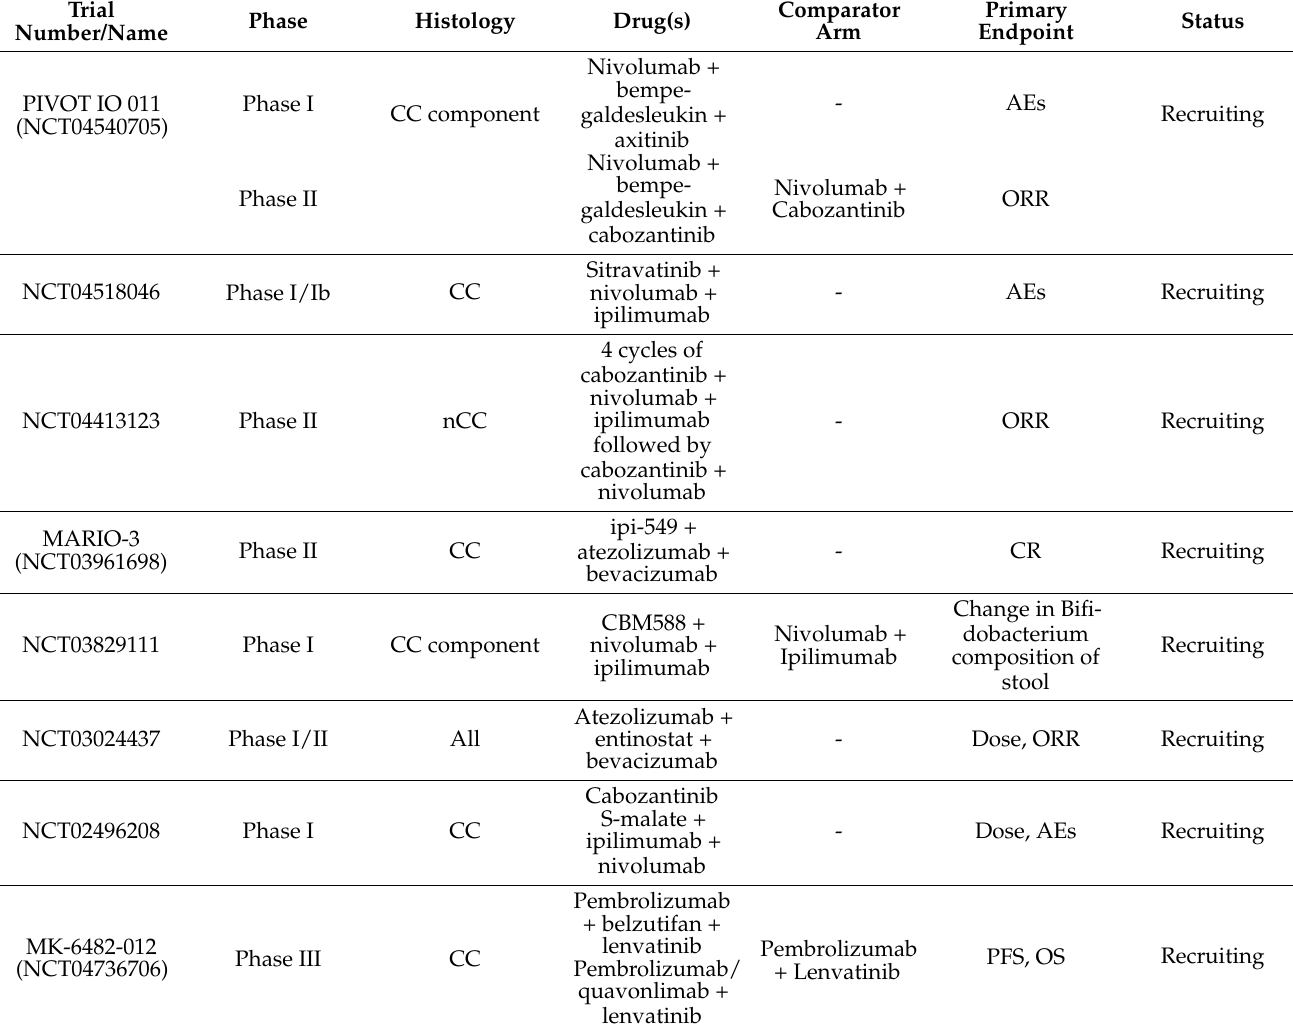
Table 5. Clinical trials investigating the combination of three or more systemic therapies in